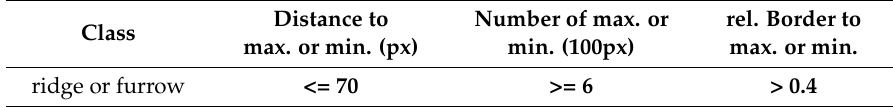
Figure 13 . Overview of the workflow in eCognition for the detection of Burial Mounds.